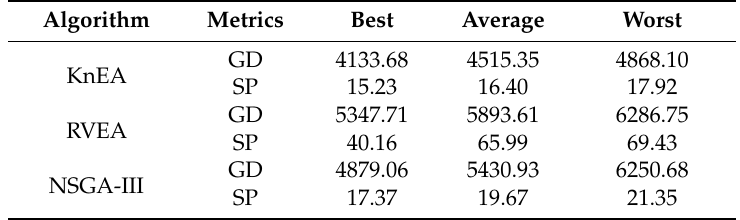
Table 2. Statistical values of two metrics for the three algorithms (GD: generational distance; SP: